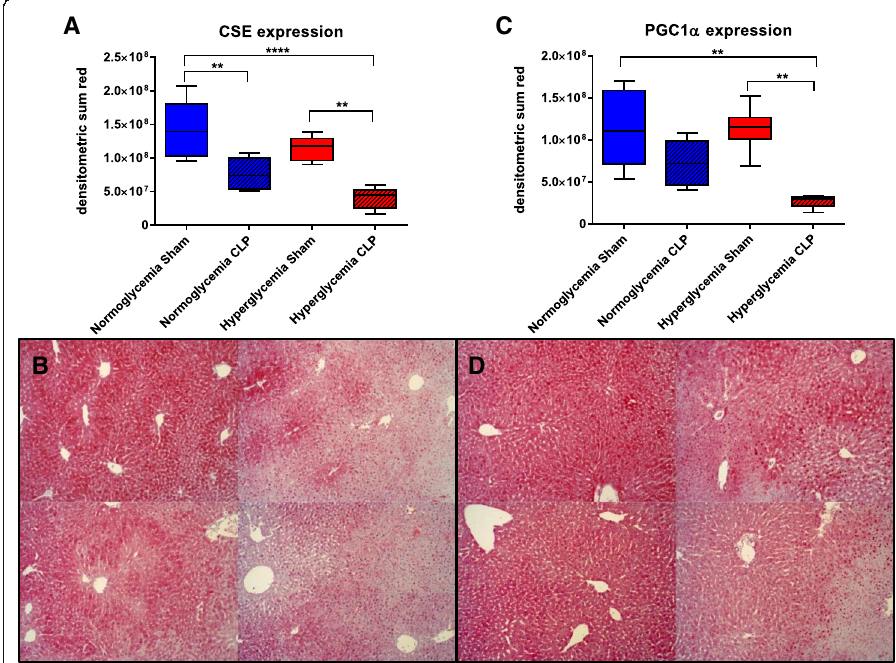
Fig. 3 Protein immunohistochemistry in the liver. a CSE expression, ** p ≤ 0.01, **** p ≤ 0.0001. b Exemplary pictures for CSE expression (10×, top left normo sham, top right normo CLP, bottom left hyper sham, bottom right hyper CLP) c PGC1 α expression, ** p ≤ 0.01 d exemplary pictures for PGC1 α expression (10×, top left normo sham, top right normo CLP, bottom left hyper sham, bottom right hyper CLP). All data is presented as median (interquartile range). Kruskal-Wallis analysis of variance on ranks with post hoc Dunn ’ s test for